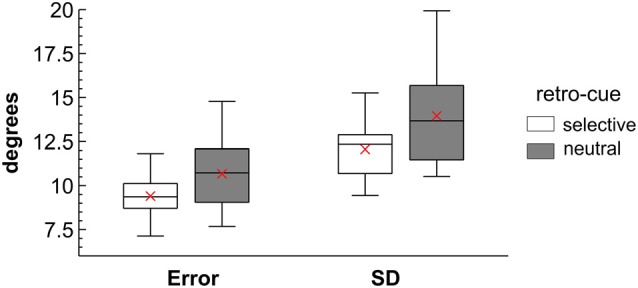
Behavioral results presented as boxplot diagrams. Shows the mean absolute angular error and the standard deviation (SD) of the error for the selective and neutral retro-cue conditions. The mean is represented by the red cross. The boxplots indicate the median, the 25% and 75% percentiles and the minimum and maximum values of the distributions.